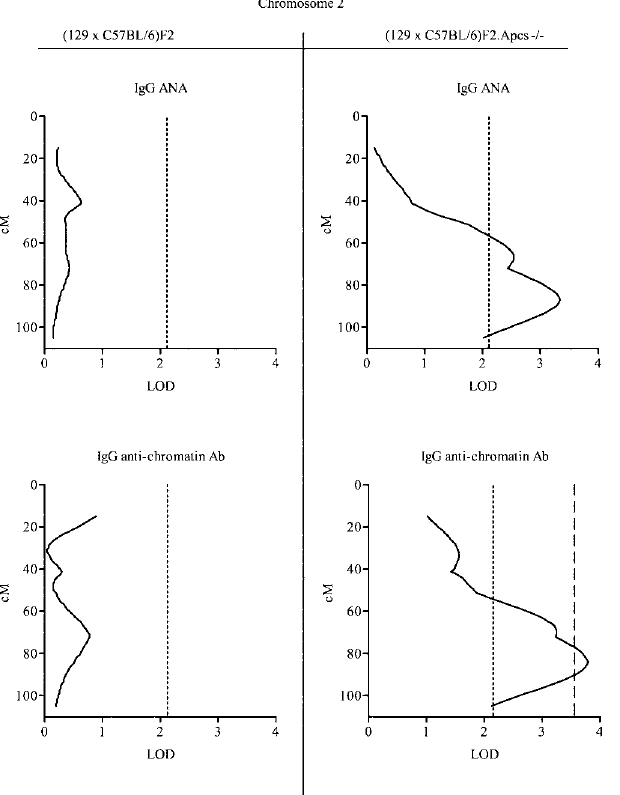
Figure 1. Linkage of Chromosome 2 with ANA and Anti-Chromatin Abs in (129 3 C57BL/6)F2 .Apcs (cid:1) / (cid:1) Mice These associations were not detected in (129 3 C57BL/6)F2 animals. Centimorgan positions were deduced by interval mapping, anchoring marker locations to data from http://www.informatics.jax.org. Dotted lines and the dashed line indicate the threshold over which linkages were considered suggestive or significant, respectively, as defined in Materials and Methods.